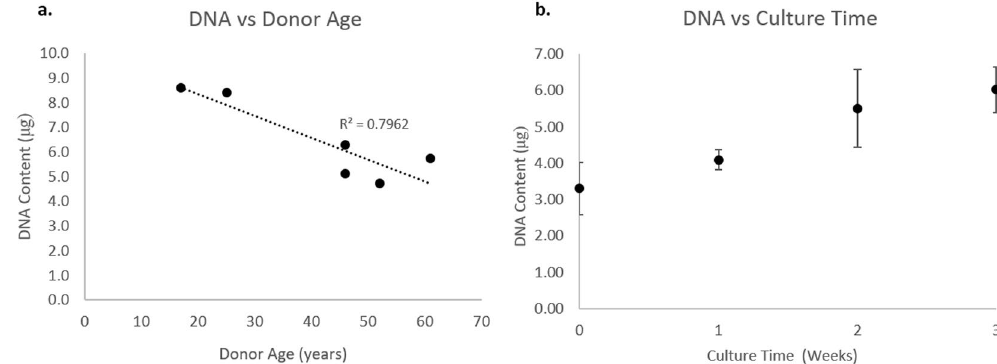
Figure 2. Left: Plot of constructs DNA content versus donor age. Density significantly decreased with increasing age p < 0.05. Right: Plot illustrating the increase in DNA over time in culture on Chondro-Gide